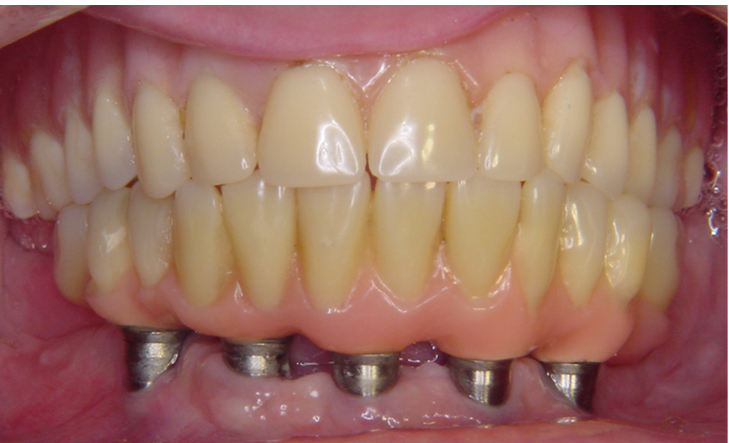
Figure 1. Clinical aspect of Brånemark protocol mandibular prostheses (experimental group), showing total implant-supported prosthesis.